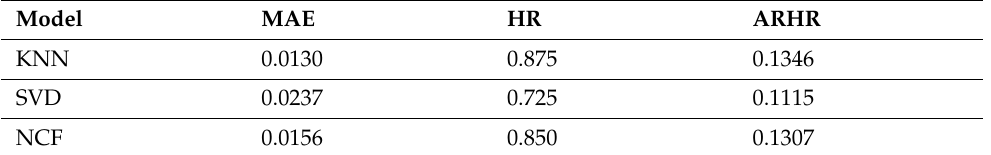
Table 1. Performance evaluation of different models (in units) in 60:40 training–testing scenario. Model